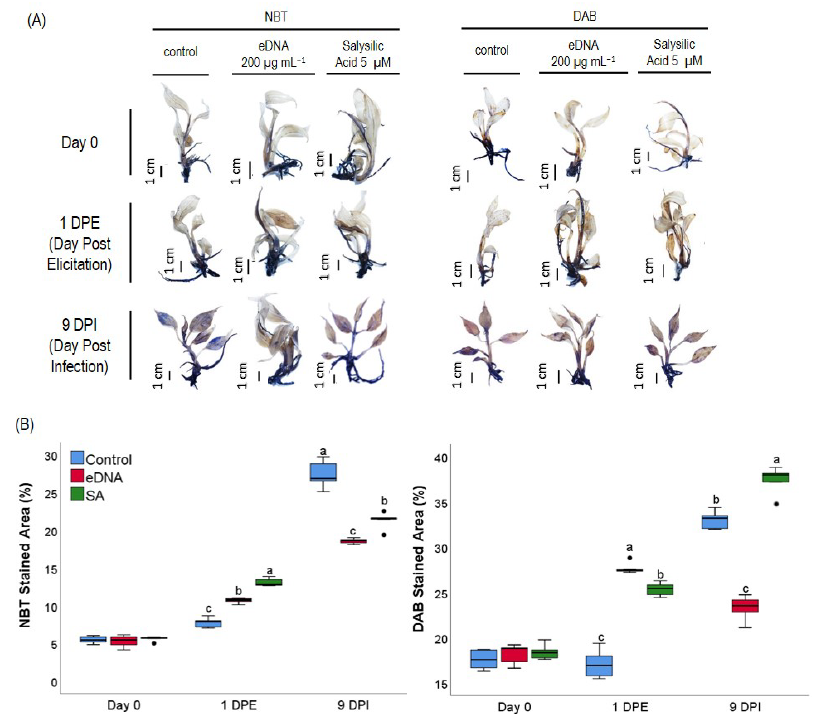
Figure 3. Detection of superoxide (O 2 − ) and hydrogen peroxide (H 2 O 2 ) production in banana plantlets. Representative staining of tissue by nitroblue tetrazolium (NBT) and diaminobenzidine (DAB), respectively, to detect O 2 − and H 2 O 2 ( A ). Quantification of the stained areas by NBT and DAB on day 0, day 1 post priming (DPP) by eDNA of Foc TR4, and day 9 post-infection (DPI) Foc TR4 ( B ). Statistically significant differences (Duncan’s test, p < 0.05) are indicated by different letters on top of the box plot corresponding to each treatment control (deionized water), eDNA of Foc TR4 (200 µ g mL − 1 ), and salicylic acid (5 µ M). The black dots represent outlier data in each sampling point.